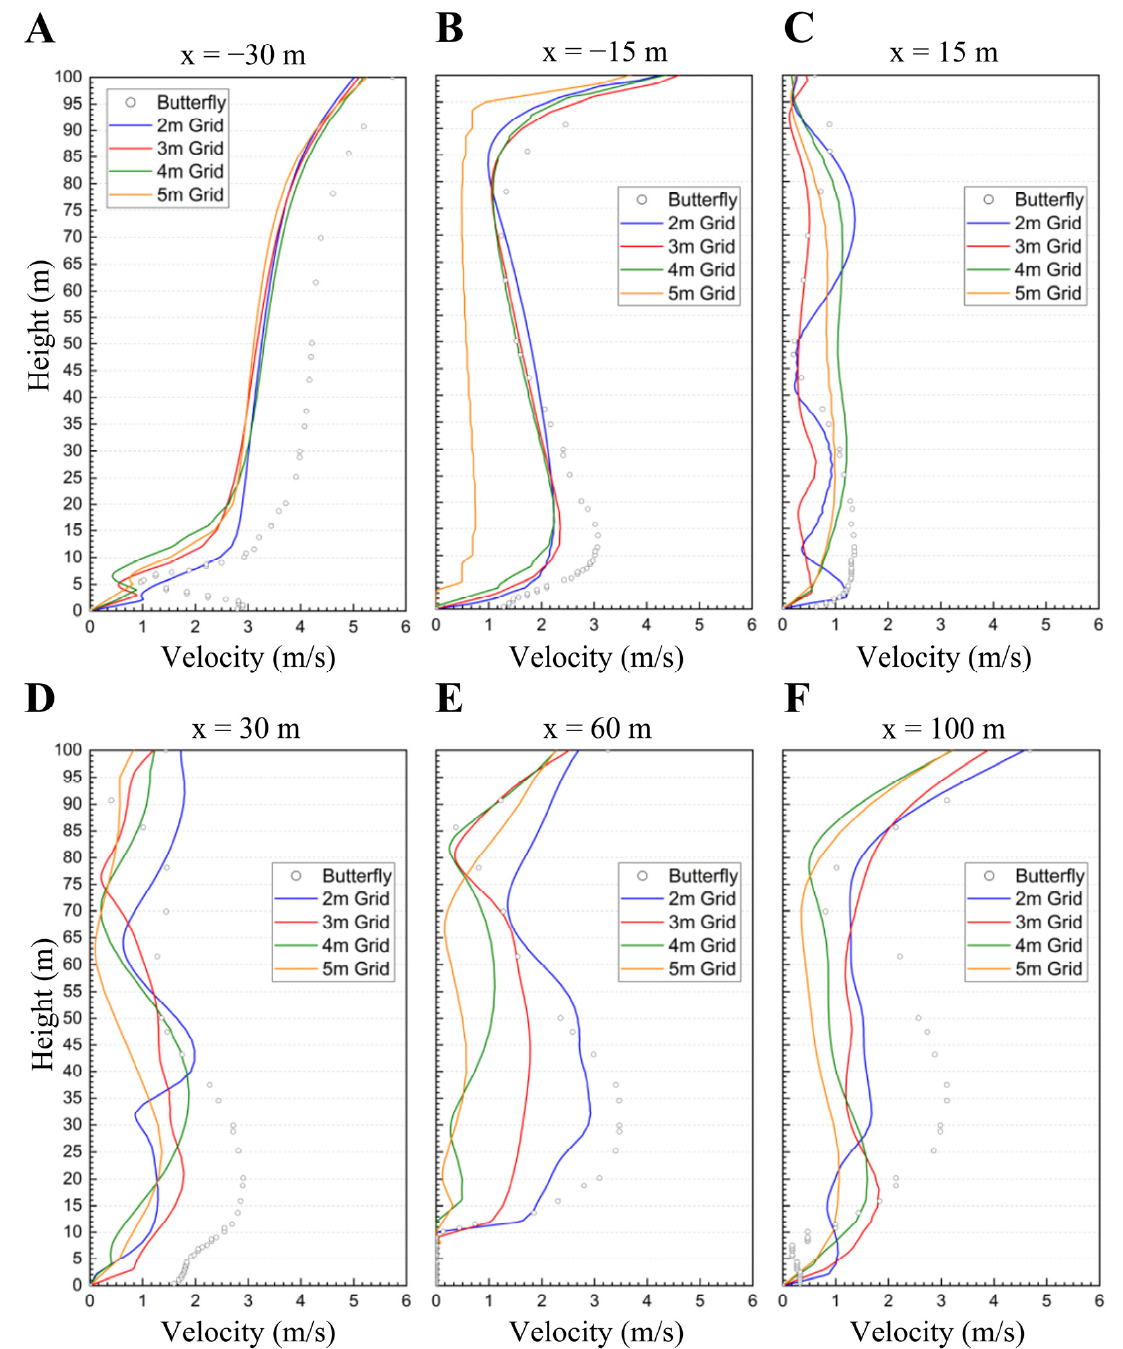
Figure 8. Wind velocity profiles on vertical planes corresponding to ( A ) x = − 30 m, ( B ) x = − 15 m, ( C ) x = 15 m, ( D ) x = 30 m, ( E ) x = 60 m, and ( F ) x = 100 m obtained by GH_Wind simulations with different grid schemes. (The x -axis is perpendicular to the inlet boundary, and the central point of the target building coincides with the origin of the x -axis.).